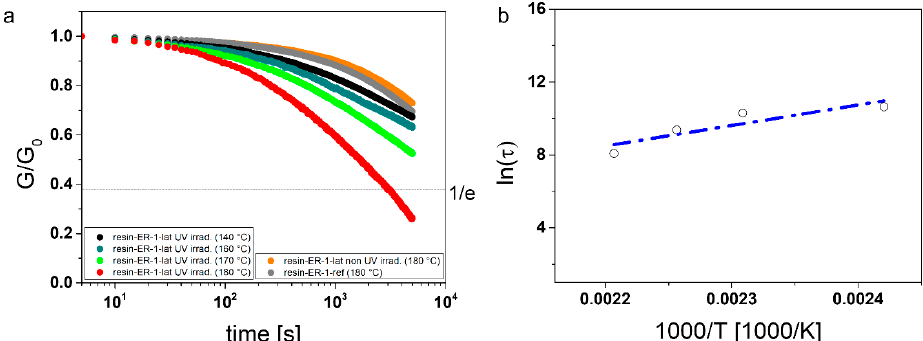
Figure 45. ( a ) Normalized stress relaxation behavior of multi-materials over time at various temperatures; ( b ) Arrhenius plot of UV-activated multi-materials derived from measured relaxation times. Reproduced from Ref. [237] with permission from the Royal Society of Chemistry.